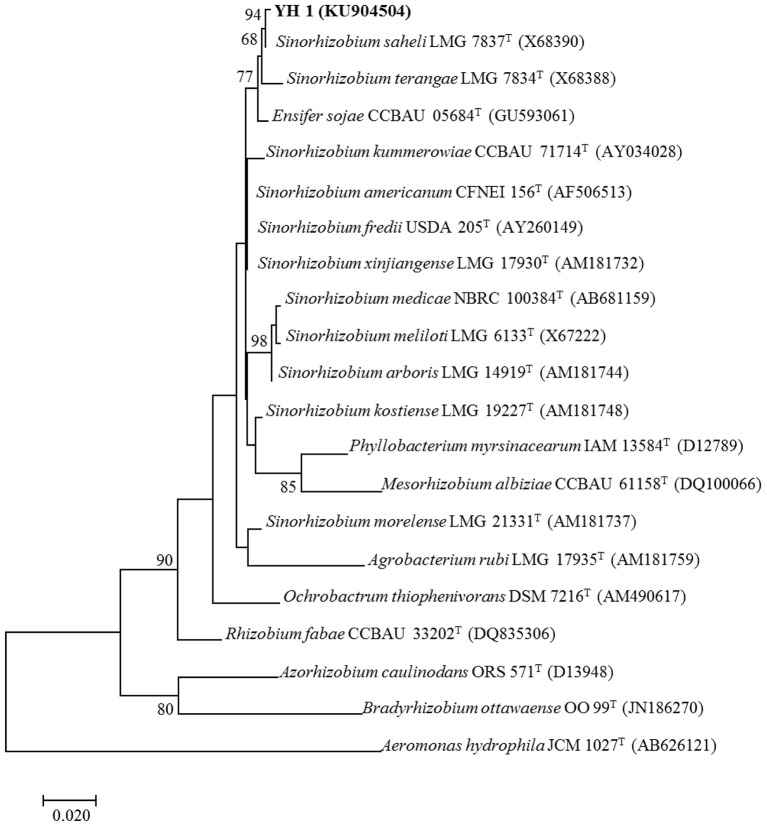
16S rRNA phylogenetic tree (1,404 bp) of L. leucocephala-isolated strain YH1 created using maximum likelihood method with the Kimura 2-parameter model. Bootstrap confidence level is based on 1,000 iterations. Accession numbers retrieved from GenBank are shown in parentheses. The scale bar implies 2% nucleotide substitutions per site. Values lower than 50 are not shown at the nodes. Superscript “T” following each strain number indicates type strain.